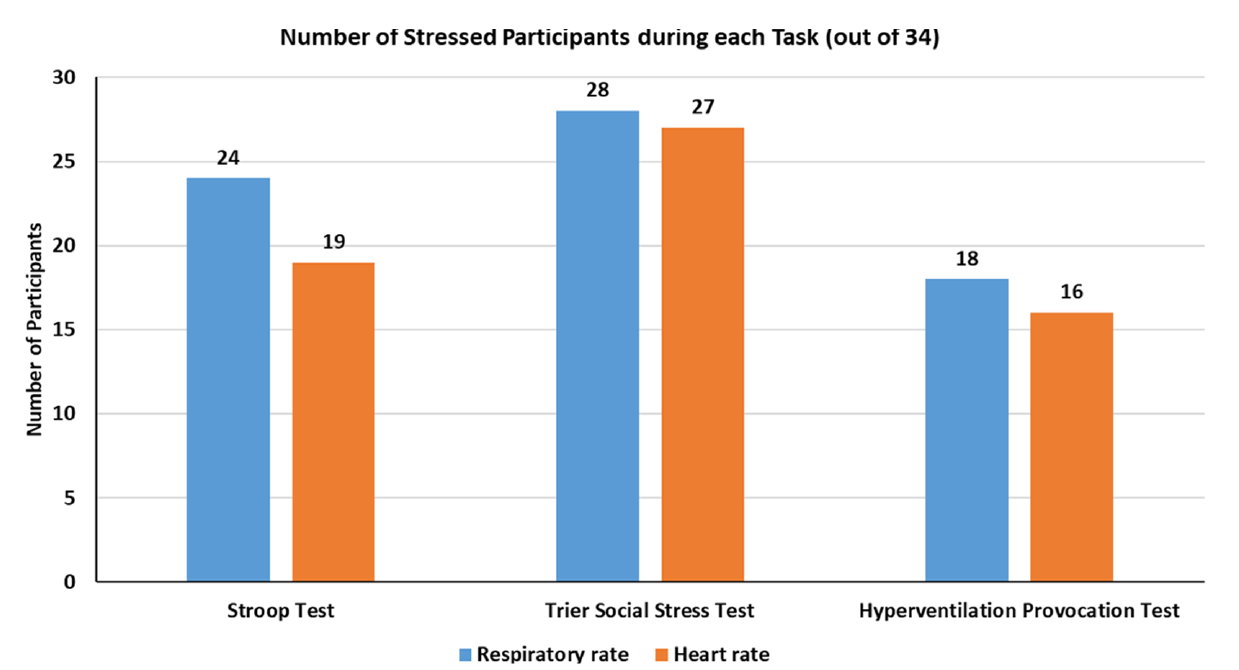
Figure 2. Participants with increased stress levels during each task. Table 2. The average number of entries (per participant).